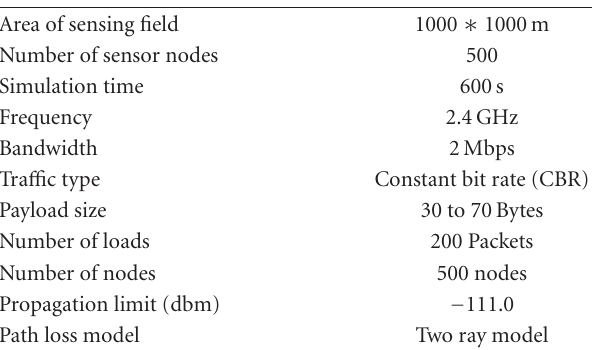
Figure 2: Flow chart for optimal hand o ff based self recovery. Table 1: Simulation